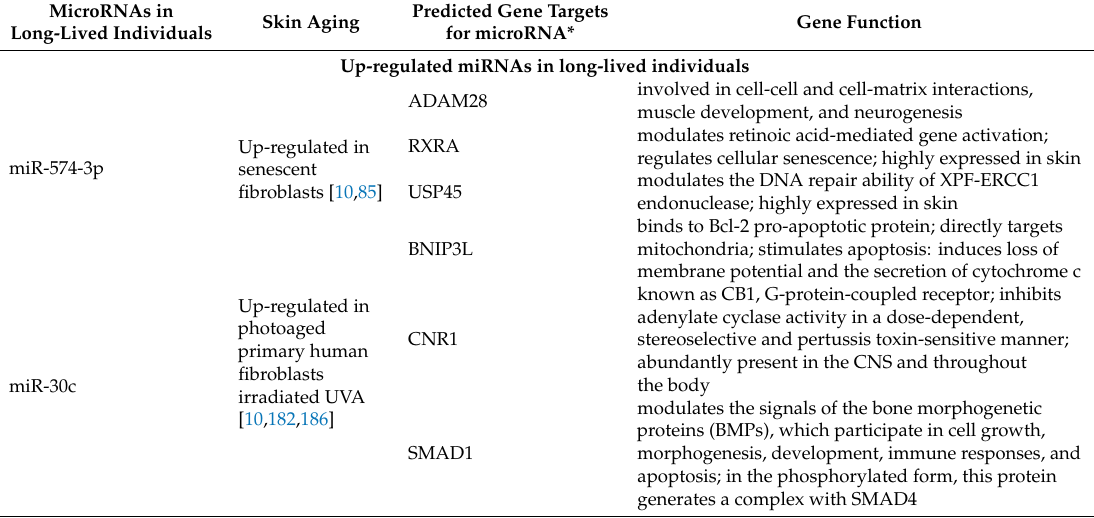
Table 3. MicroRNA expression in the skin of long-lived individuals with a prediction of functional miRNA